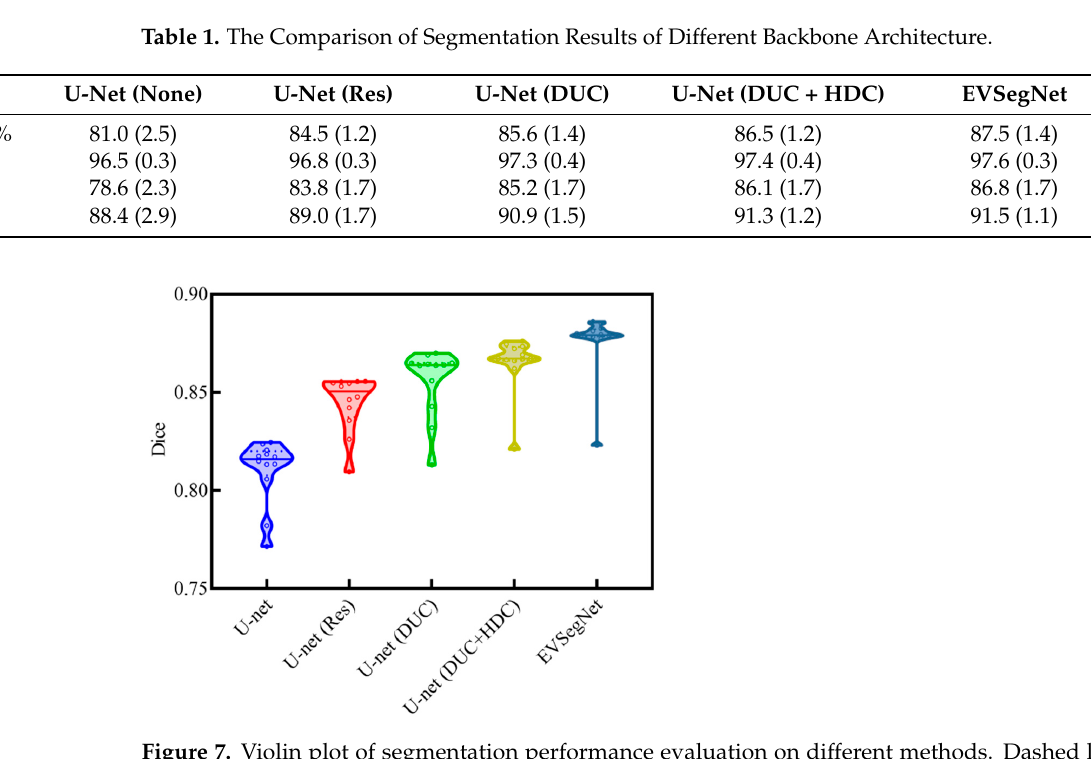
Figure 7. Violin plot of segmentation performance evaluation on different methods. Dashed line shows the 25th and 75th percentiles. The solid line represents the mean value. In this work, we evaluated the U-net (Res), U-net (DUC), U-net (DUC + HDC), and EVSegNet.